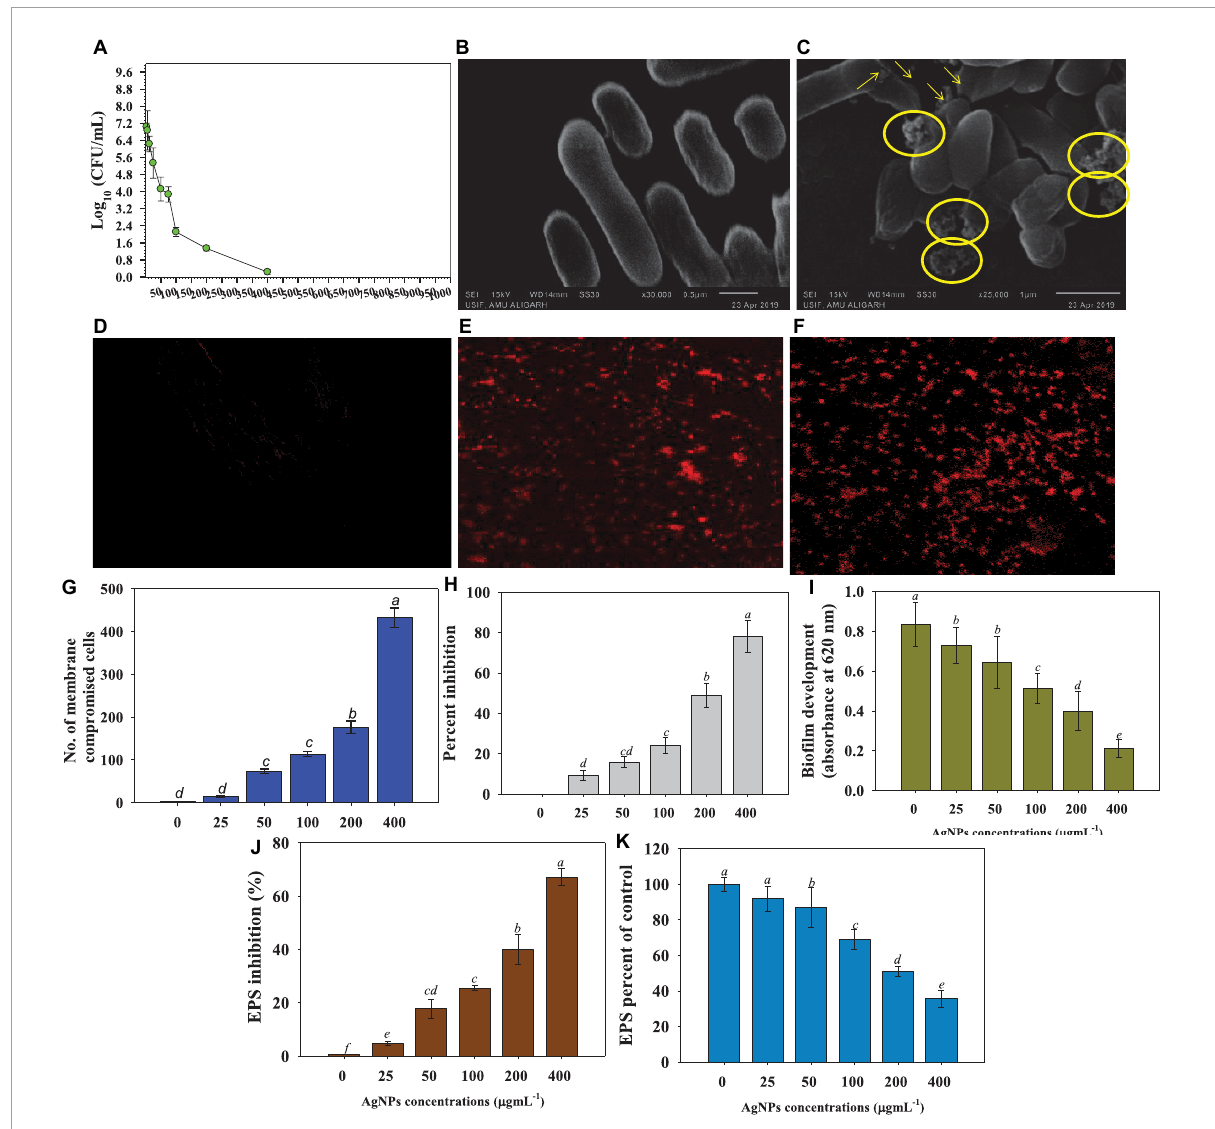
FIGURE3 Anti-bacterial properties of increasing concentrations of Cassia fistula leaf synthesized silver nanoparticles (Ag@ Cf L-NPs) against soil bacterial pathogen Pseudomonas syringae ; effect of 0–1,000 µ g Ag@ Cf L-NPs ml − 1 on CFU count (A) , morphological changes: control cells of P . syringae (B) treated with 100 µ g Ag@ Cf L-NPs ml − 1 (C) , NP-induced cellular permeability: CLSM images of untreated bacterial cells showing no bacterial uptake of propidium iodide (D) , treated with 100 µ g Ag@ Cf L-NPs ml − 1 (E) and 200 µ g Ag@ Cf L-NPs ml − 1 showing the red-colored rod-shaped cells (F) , number of membrane compromised cells (G) , percent inhibition in bacterial biofilm formation (H) , biofilm development in the presence of increasing doses of Ag@ Cf L-NPs (I) , percent inhibition in bacterial EPS (J) and EPS percent of control (K) . In this figure, bar diagrams represent the mean values of three replicates ( n = 3). Corresponding error bars represents standard deviation (S.D) of three replicates (S.D, n =